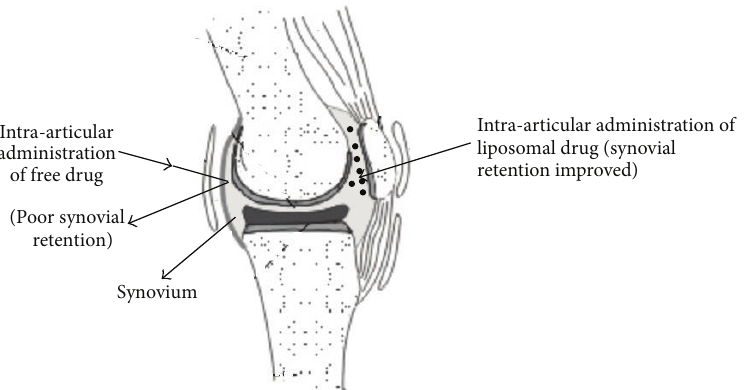
Figure 2: Rationale for the use of liposomes in rheumatoid